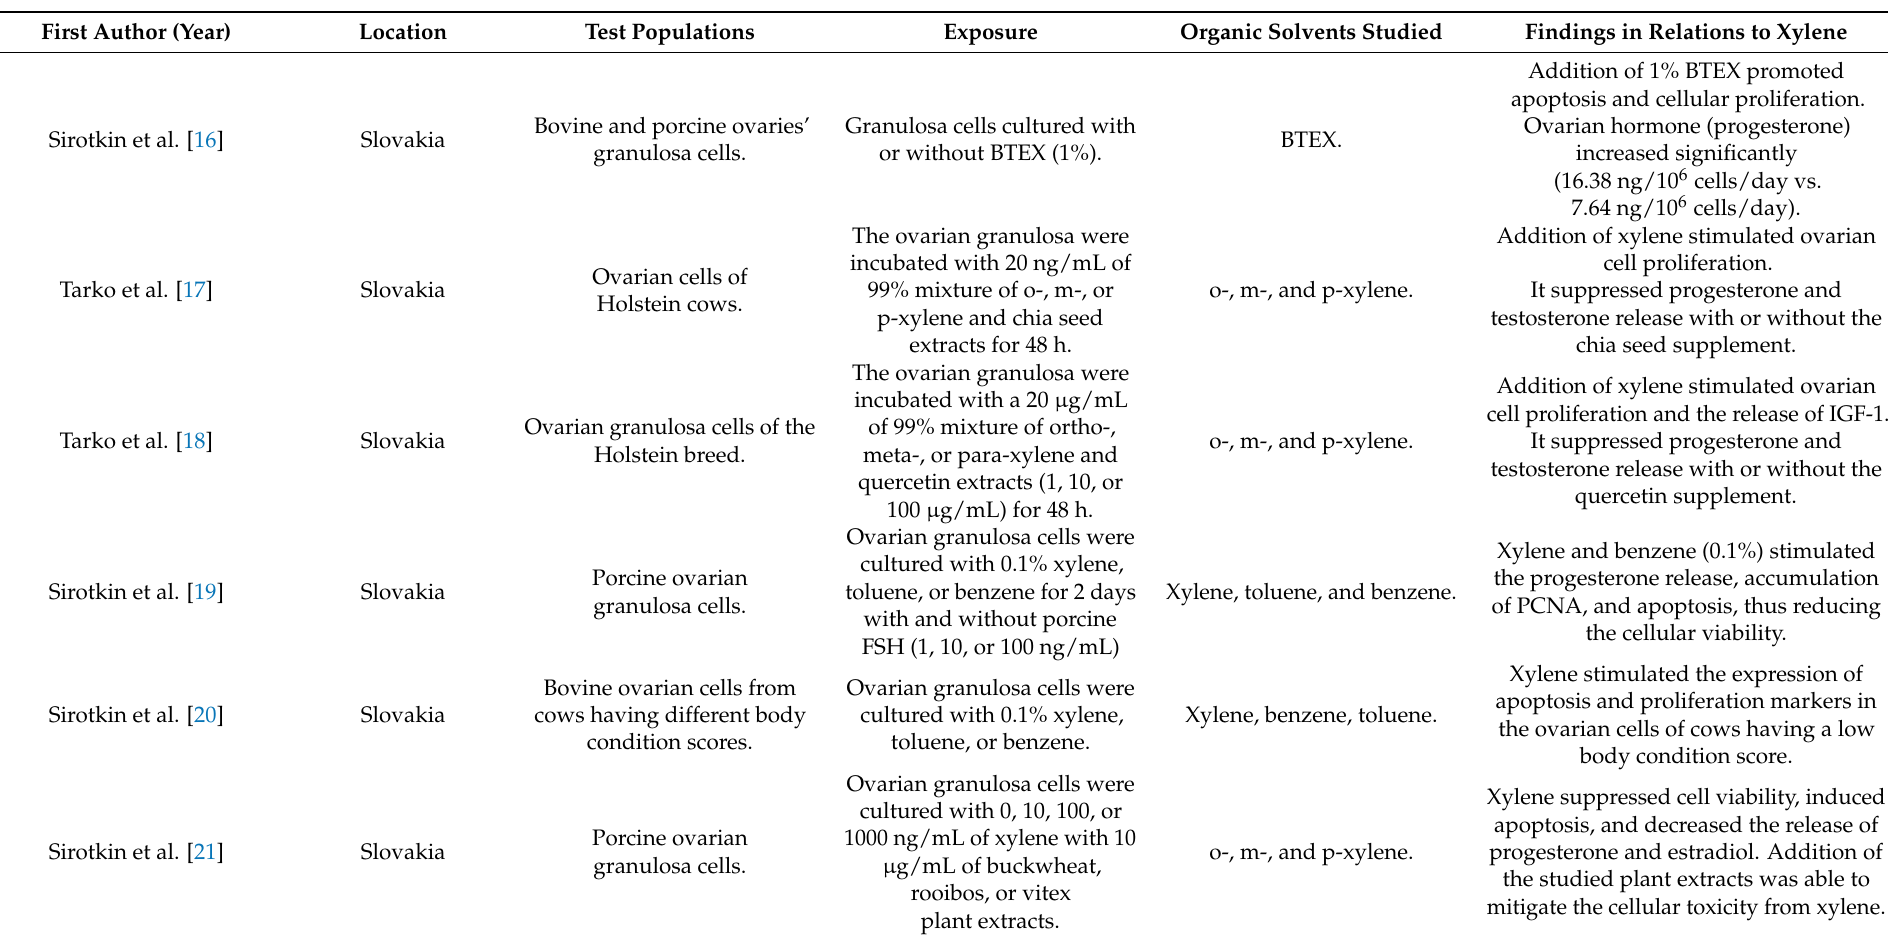
Table 4. In vitro studies on the toxicity of technical xylene to the female reproductive system from 1990 to